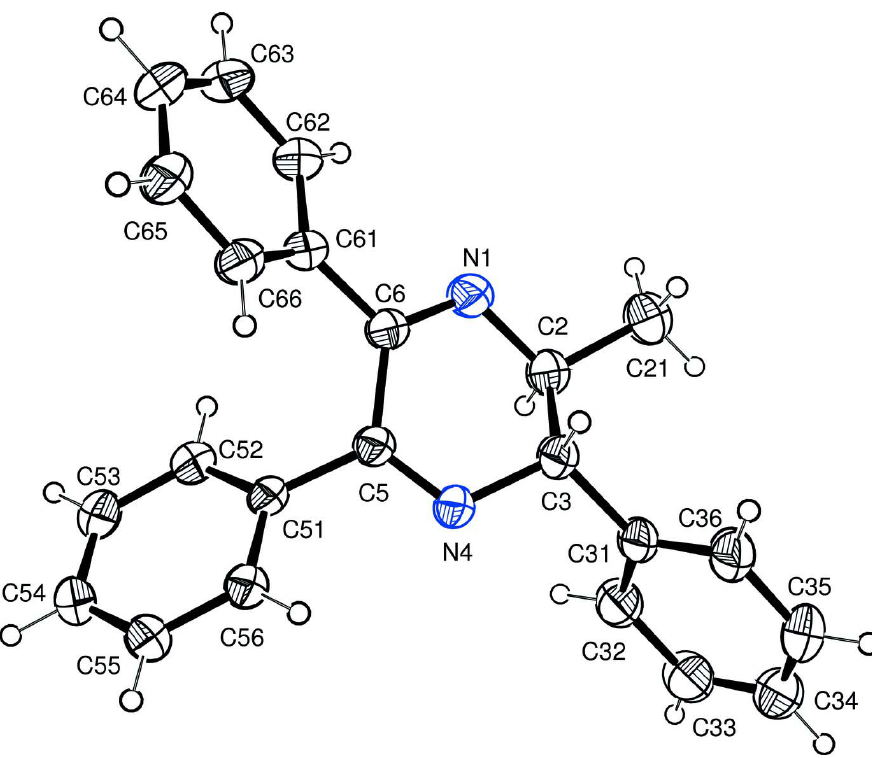
Figure 1 The molecular structure of (I), showing the atom-numbering scheme and displacement ellipsoids drawn at the 30% probability level. H atoms are shown as small spheres of arbitrary